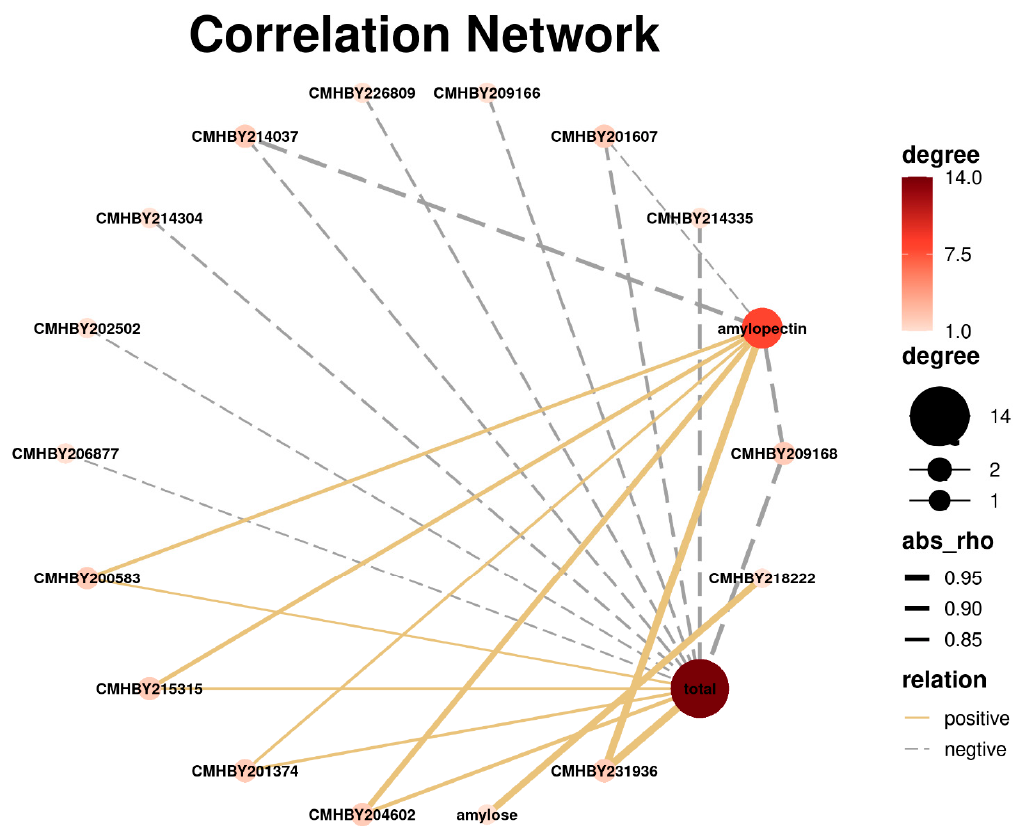
Figure 7. Correlation networks between the starch concentrations (amylose, amylopectin, and total) and the starch biosynthesis-related gene expression profiles. Solid yellow lines represent positive and dotted gray lines represent negative correlation, whereas dot size/color denotes the quantity of correlated objects.